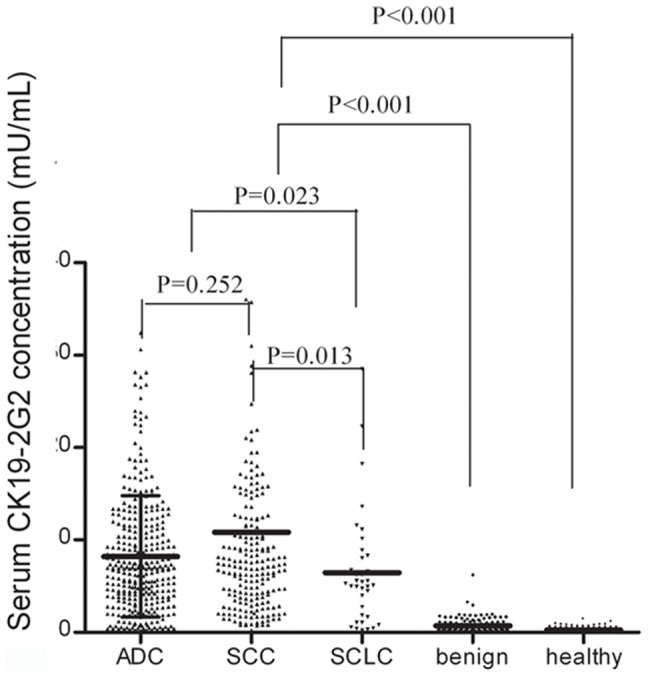
Serum CK19-2G2 concentrations in lung cancer patients, patients with benign diseases and healthy controls.The scatter represents a single value and the lines represent the mean levels of CK19-2G2 for the benign, healthy and malignant histology subtypes. Abbreviations: ADC: adenocarcinoma; SCC: squamous carcinoma; SCLC: small cell lung cancer.